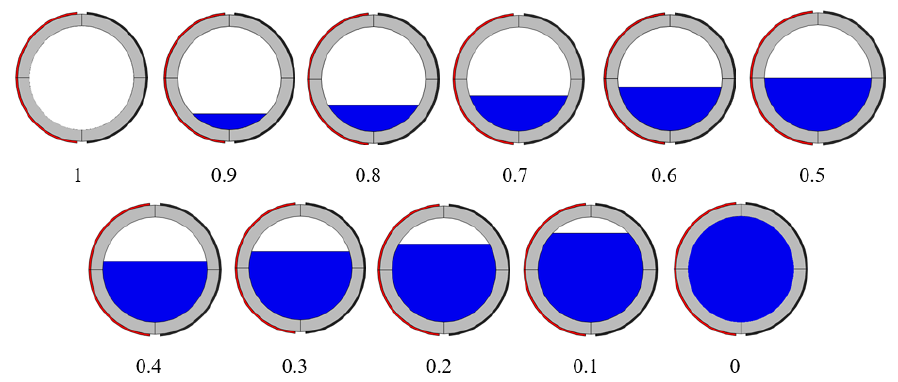
Figure 5. Different water levels in the cross-section of the pipe for a different void fraction in COMSOL, where the blue color represents the water level, the gray color represents the pipe, and the red and black colors represent the electrodes.